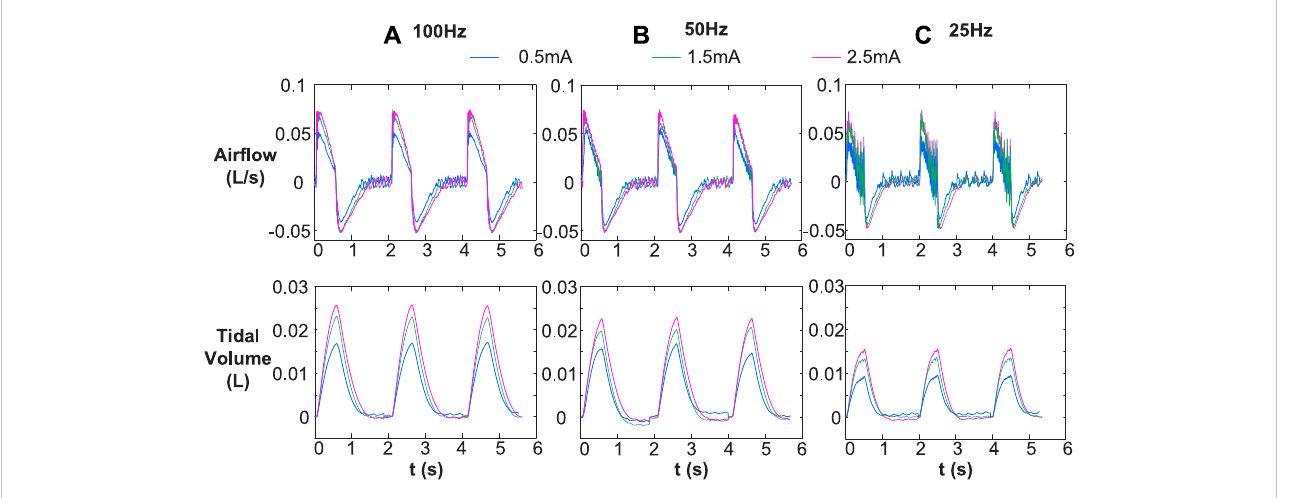
FIGURE 4 Comparison of inspired air fl ow and tidal volume under different stimulus frequencies [ (A) 100 Hz, (B) 50 Hz, and (C) 25 Hz] with various stimulus amplitudes (.5, 1.5, an 2.5 mA). Other stimulus parameters were same, for 30 breath/min, 160 μ s and .5 s, respectively. Different stimulation frequencies (25, 50, and 100 Hz) cause single and complete contraction of the diaphragm, and the corresponding tidal volume increase with the increase of stimulation frequency and amplitude.